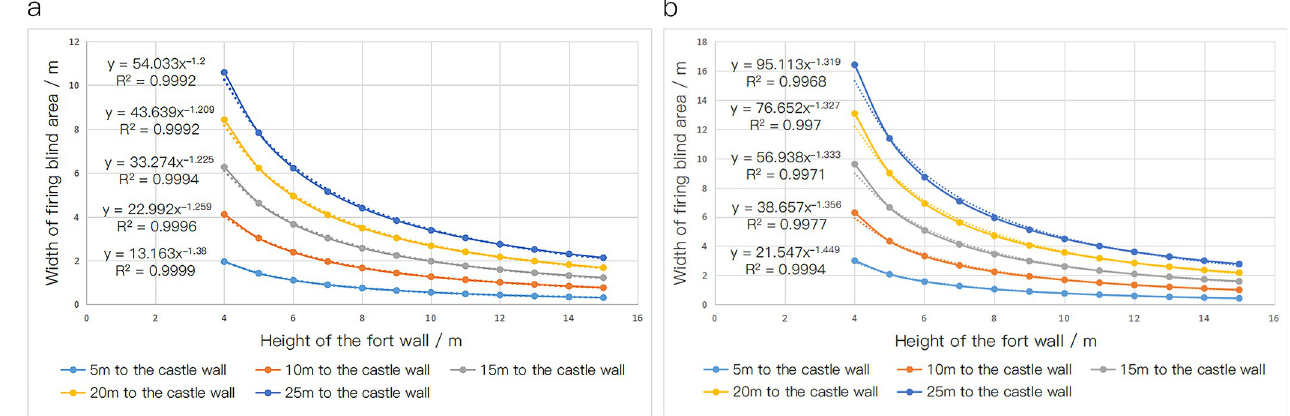
Fig 14. Scatter plot of the width of the firing blind area of Eight-Chi (2.56 m) Yangmacheng (a) and scatter plot of the width of the firing blind area of ten-Chi (3.20 m) Yangmacheng (b). https://doi.org/10.1371/journal.pone.0282537.g014 wall. Additionally, it is hypothesized that the three defensive levels outside the city are intrinsi- cally linked and comprise a systemic totality. In addition, it is connected to the weapon range, firing network density, and ancient army defensive operation style. Field research, 3D point cloud photography, and modeling were carried out on the ruins of the Puzhuang Suo-Fort in